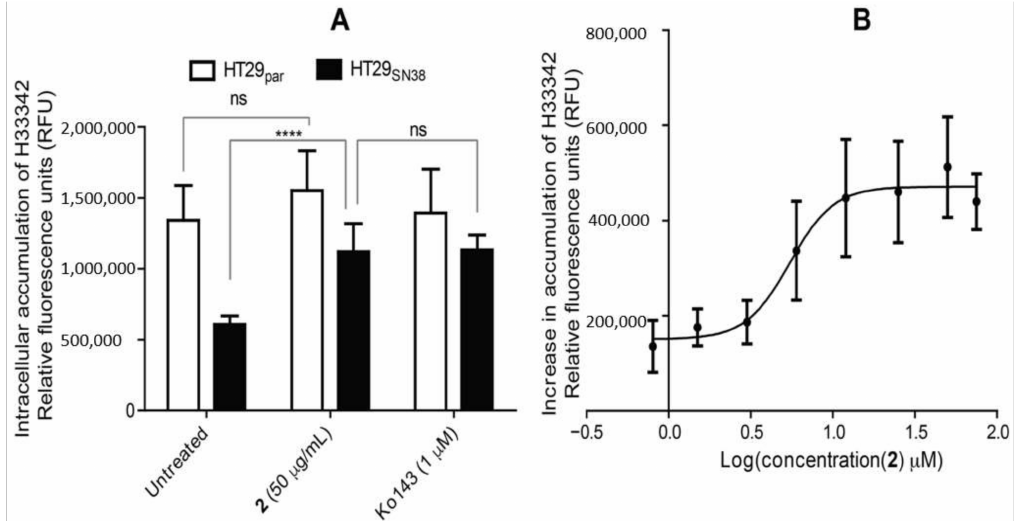
Figure 9. ( A ) Intracellular accumulation of H33342, expressed as relative fluorescence units (RFU) with excitation/emission 346/460, in untreated cells and cells treated with 2 or Ko143, all in the presence of 5 µ g/mL H33342. Black: HT29 SN38 , white: HT29 par . Error bars indicate SD determined on the basis of n = 6. ( B ) Dose–response curve for compound 2 with increase in accumulation of H33342 in HT29 SN38 (relative to untreated control cells) measured as RFUs. Data for the dose–response curve are plotted as the mean of the mean of three biological replicates, and error bars indicate SEM with n = 3. **** p ≤ 0.0001, ns = not statistically